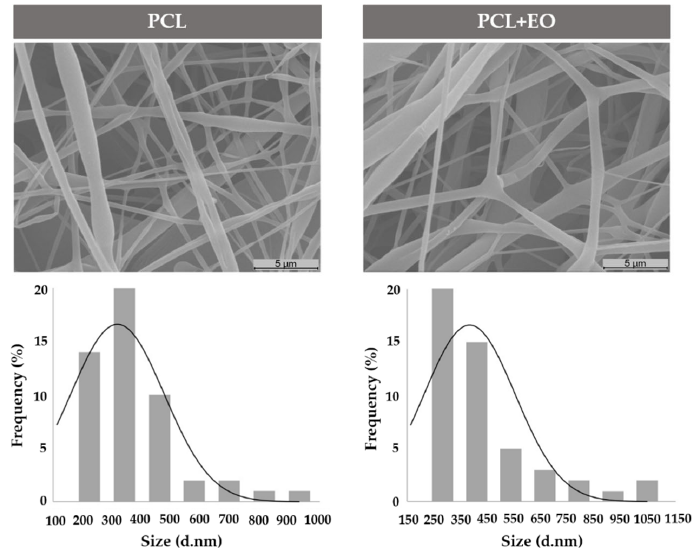
Figure 3. Scanning Electron Microscopy (SEM) images of the nanofibers of the PCL and PCL + EO